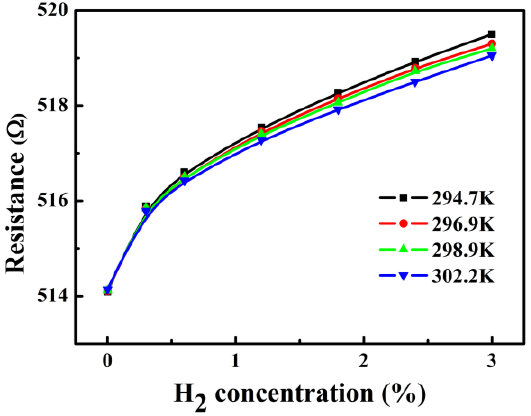
Figure 7. Resistances of the PdNi film under various H 2 concentrations with the temperature correction.